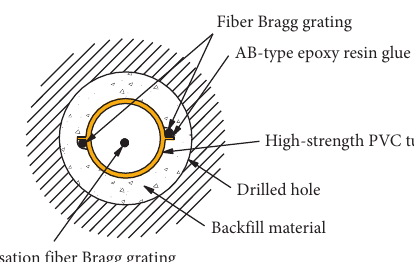
Figure 7: Schematic diagram of the cross-section of the monitoring hole installed with fiber grating.